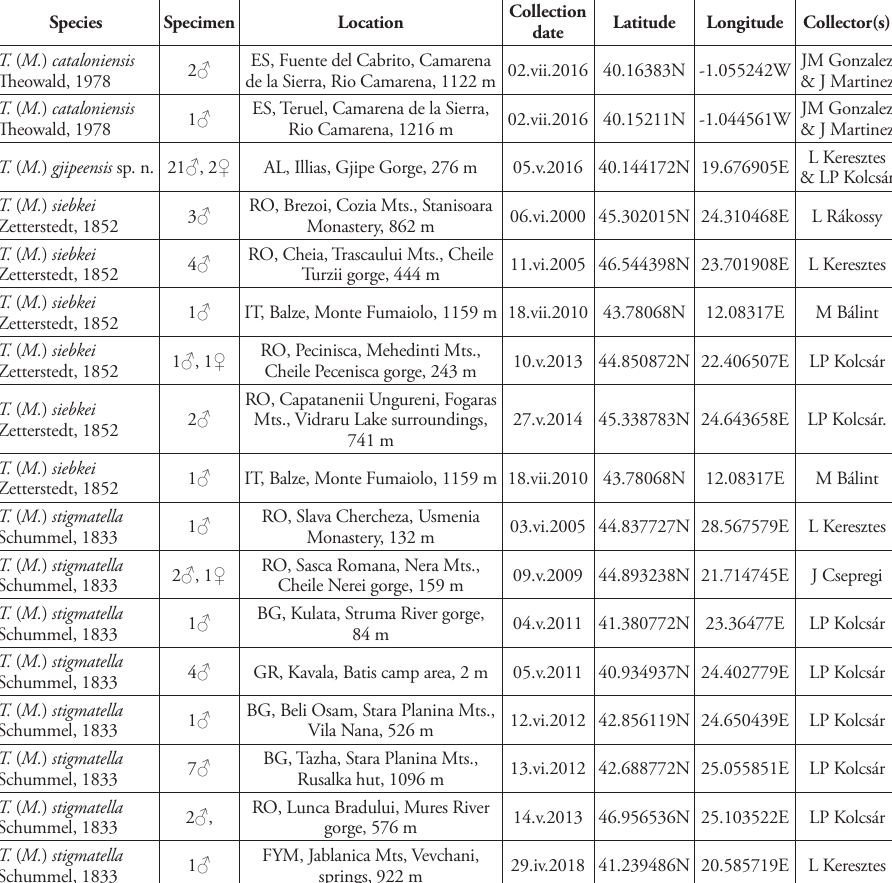
Table 1. Material of the subgenus Mediotipula used in our study with localities (BG-Bulgaria, FYM- Macedonia, GR-Greece, IT-Italy, ES-Spain), geographic coordinates (given in decimal degrees), number of individuals found at each collection site, number of individuals used in the present study, date of the collection, and name of collector